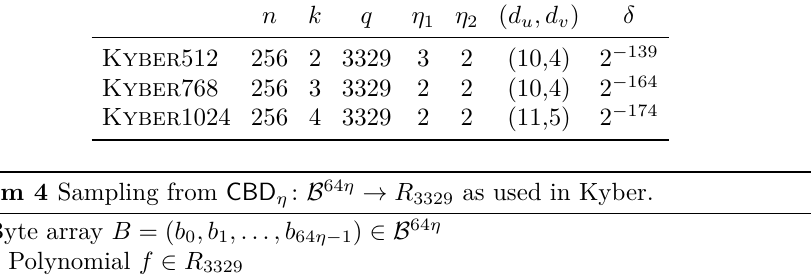
Table 3: Recommended parameter sets for Kyber .